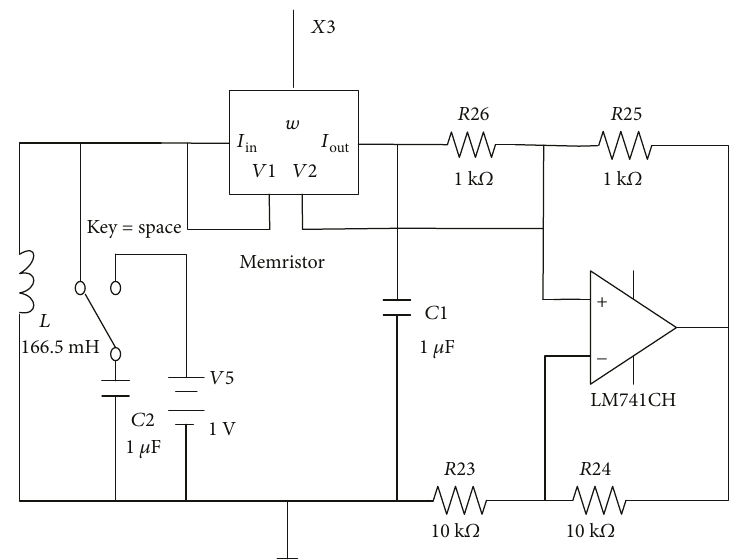
Figure 3: The new hyperchaotic memristive circuit.